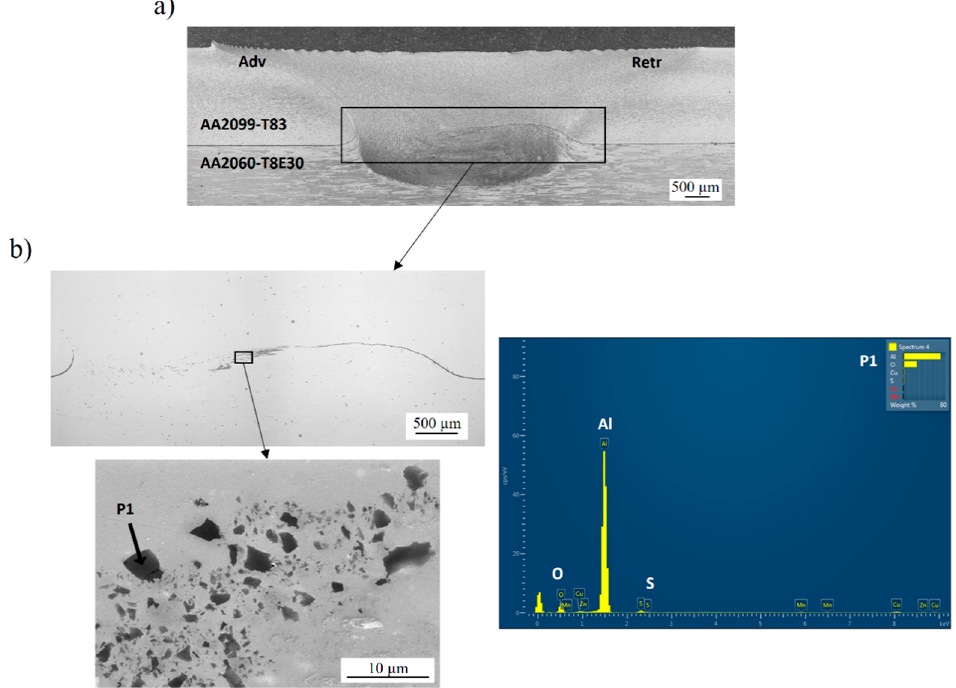
Figure 9. ( a ) Cross-sectional macrograph of the FSW weld from coupon C2 and ( b ) details of the SZ interface by optical microscopy, SEM, and EDS analysis of the fragment remnants.